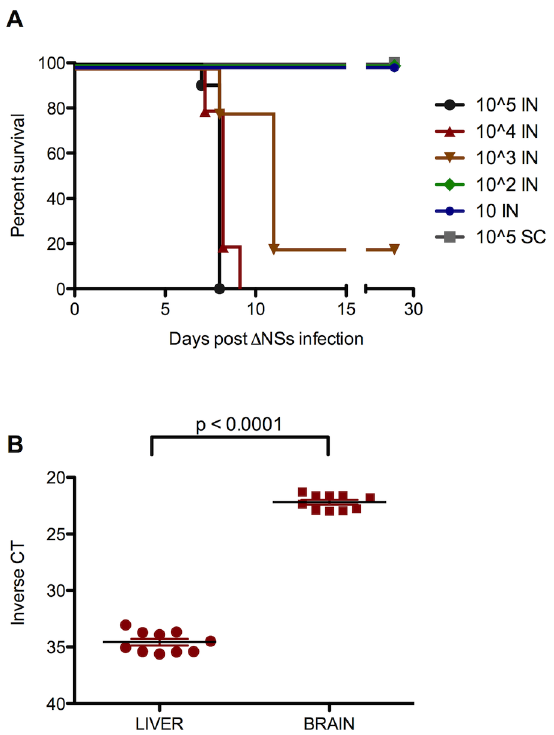
Figure 1. Intranasal inoculation results in fatal encephalitic disease. C57BL/6 mice were inoculated with various doses of Rift Valley fever virus (RVFV) lacking the NSs gene ( D NSs) intranasally (IN) or subcutaneously in the footpad (FP). (A) FP-inoculated mice survived with no indication of clinical signs. IN-inoculated mice developed dose- dependent disease. Survival curves were significantly different (p , 0.0001). (B) All mice that succumbed to D NSs virus IN infection at high doses (1 6 10 4 or 1 6 10 5 TCID 50 /per nare) had significantly higher viral RNA loads in the brain than in the liver, as measured by RVFV-specific qRT-PCR (p ,